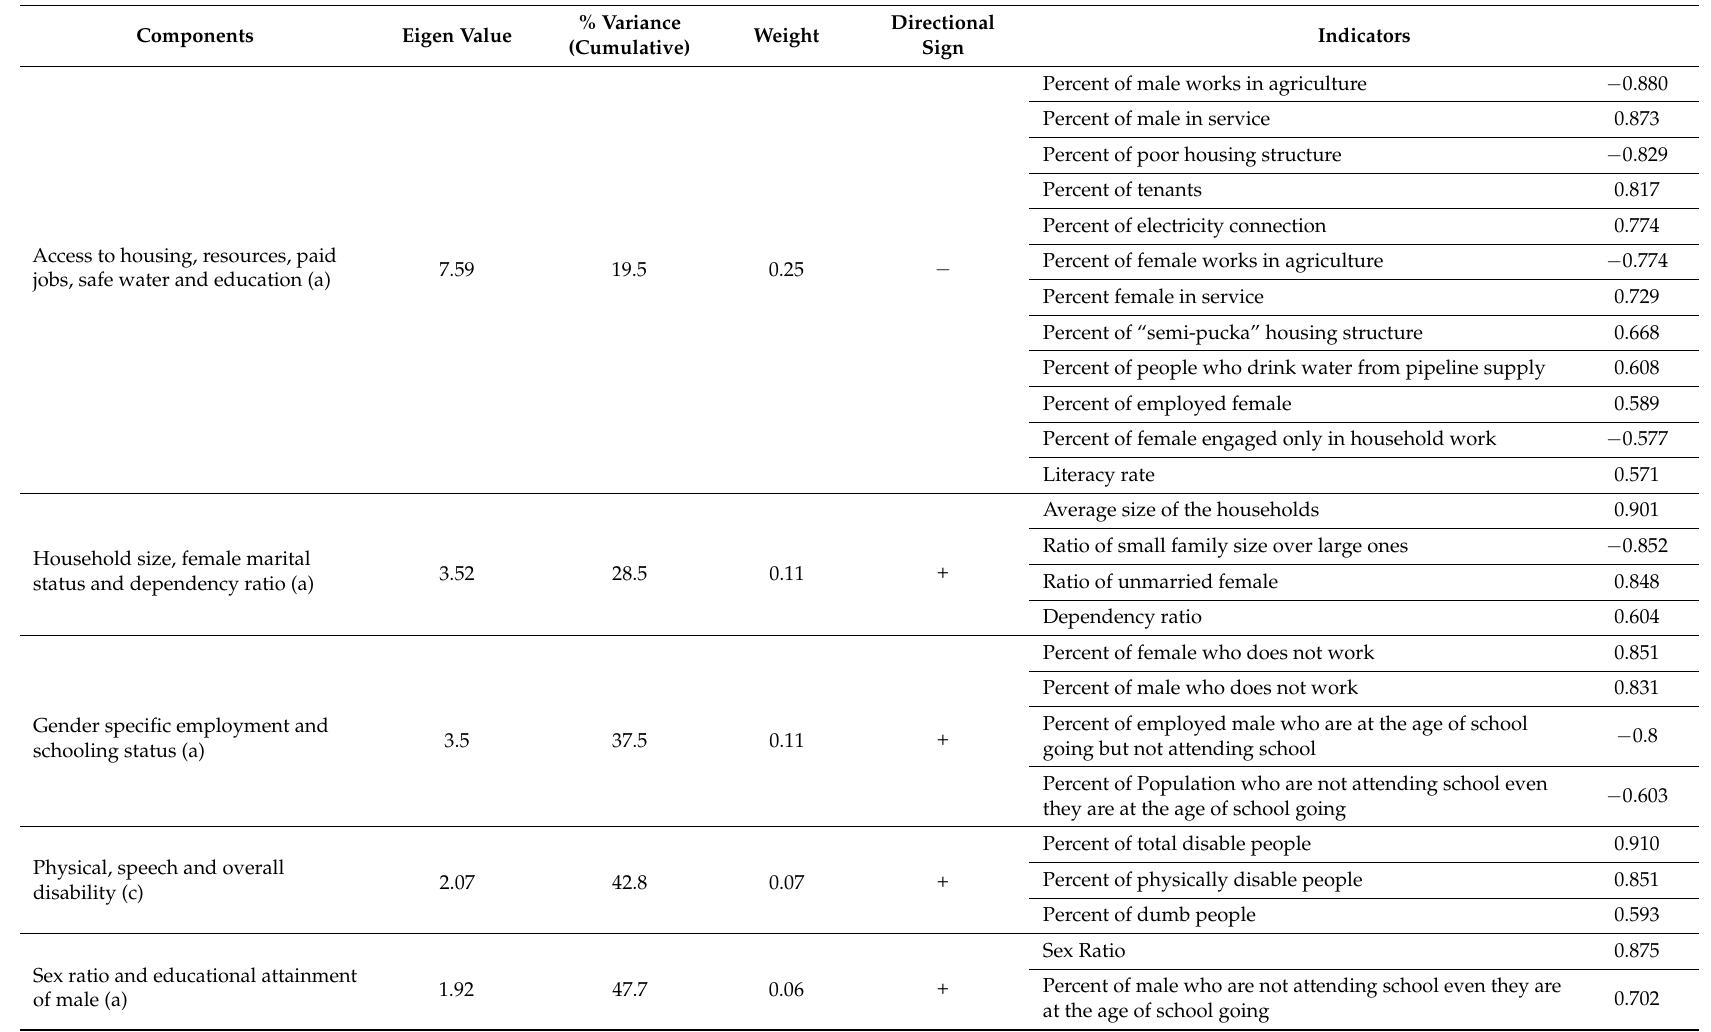
Table 1. Socio-Economic variables and their directional effects on